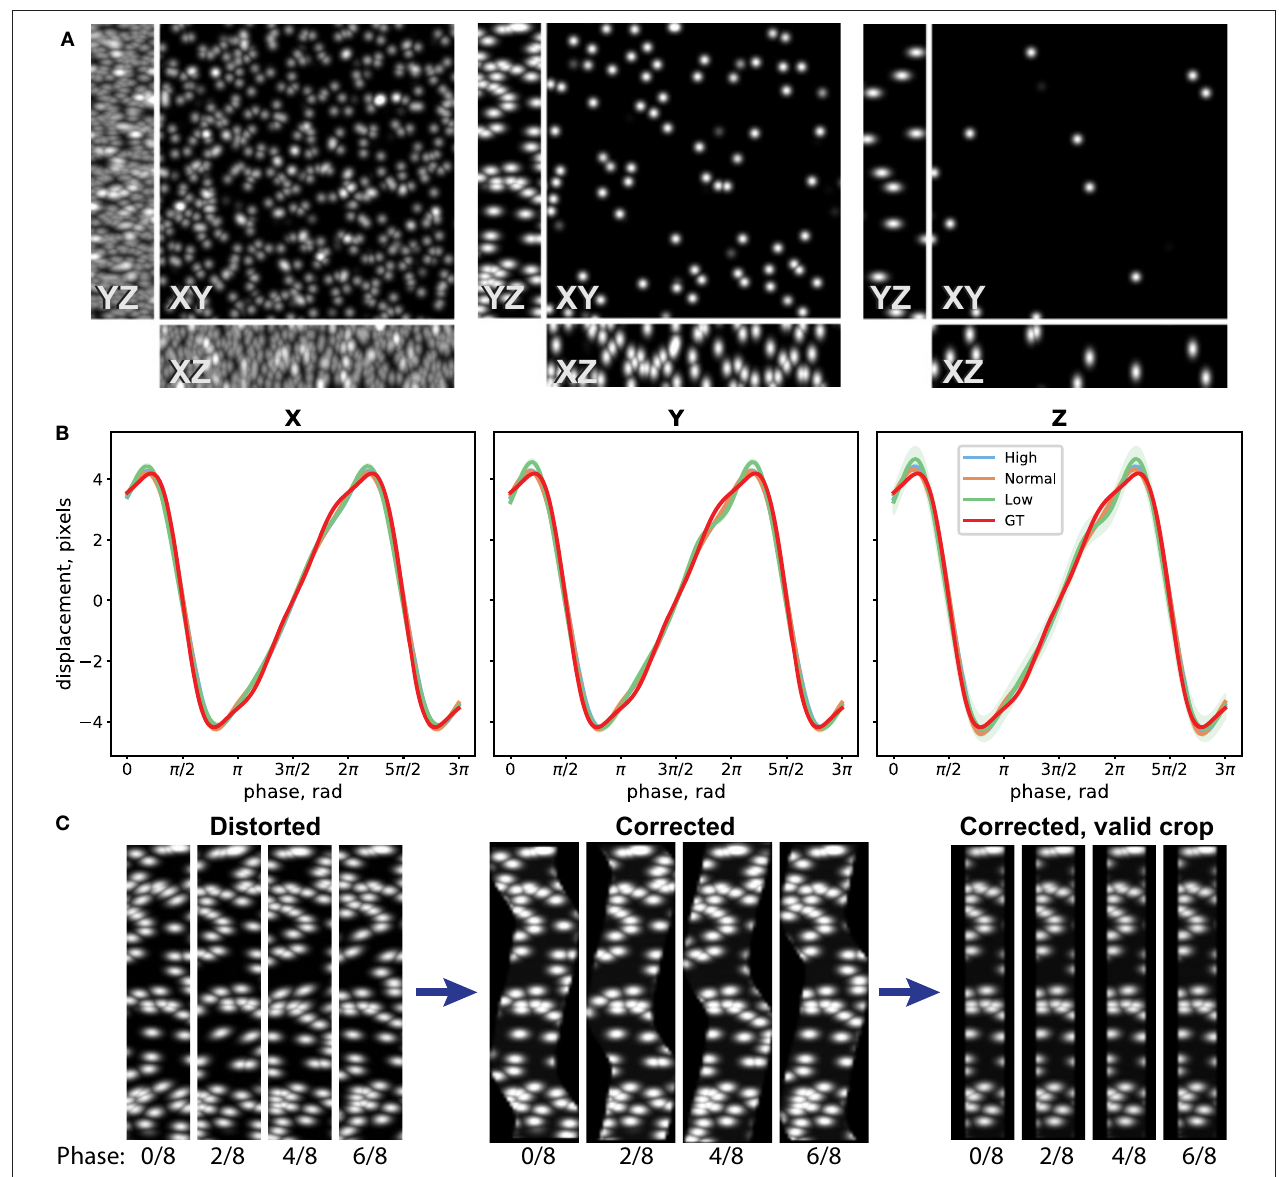
FIGURE 3 | Evaluation of the distortion measurement and correction procedure on synthetic datasets. (A) Maximum intensity projections (MIP) of one Z stack of three synthetic datasets with high, normal, and low densities of Gaussian spots, used as landmarks for distortion measurement. (B) Reconstruction of distortion profile for the three datasets and the ground truth (GT) profile. Eight-node spline fit is performed. (C) YZ MIPs for the normal-density distorted data, reconstructed data according to the measured distortion, and crop of the valid data volume are shown for four different